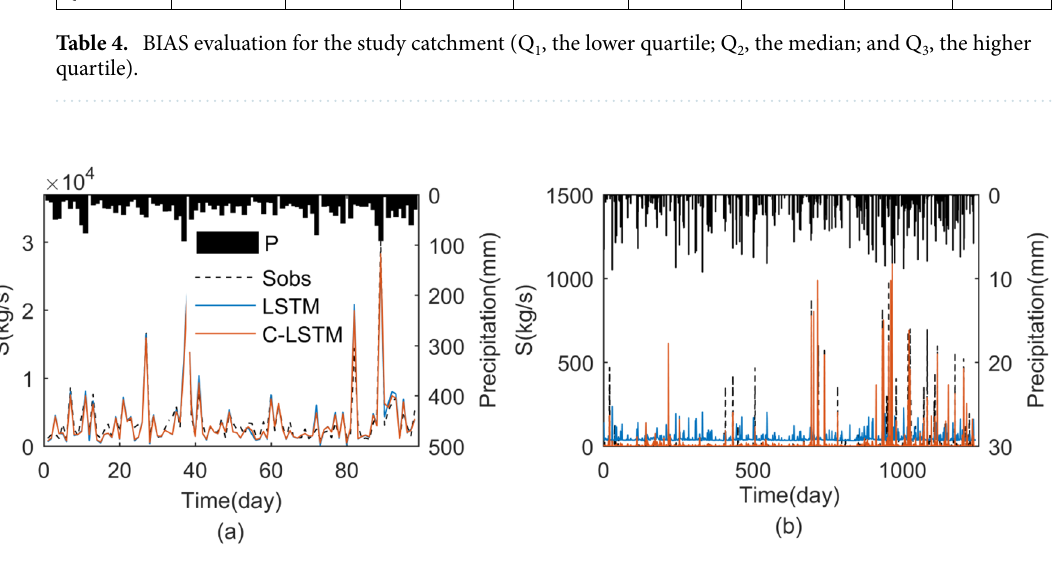
Figure 6. Comparison between observed and estimated sediment using the two schemes for Patten1 ( a ) and Patten2 ( b